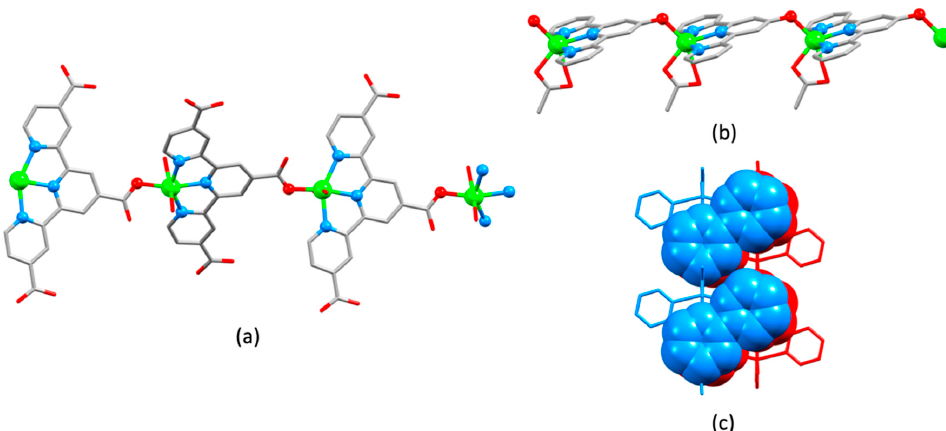
Figure 8. Part of the 1D-coordination polymers in ( a ) [Zn(H 12 )(OH 2 ) 2 ] n · 2 n H 2 O (CSD refcode CESRAW), and ( b ) [Zn(4 (cid:48) - O-2,2 (cid:48) :6 (cid:48) ,2 (cid:48)(cid:48) -tpy)(OAc)] n (refcode WUKBAH). ( c ) Adjacent chains in [Zn(4 (cid:48) -O-2,2 (cid:48) :6 (cid:48) ,2 (cid:48)(cid:48) -tpy)(OAc)] n associate through face-to-face π